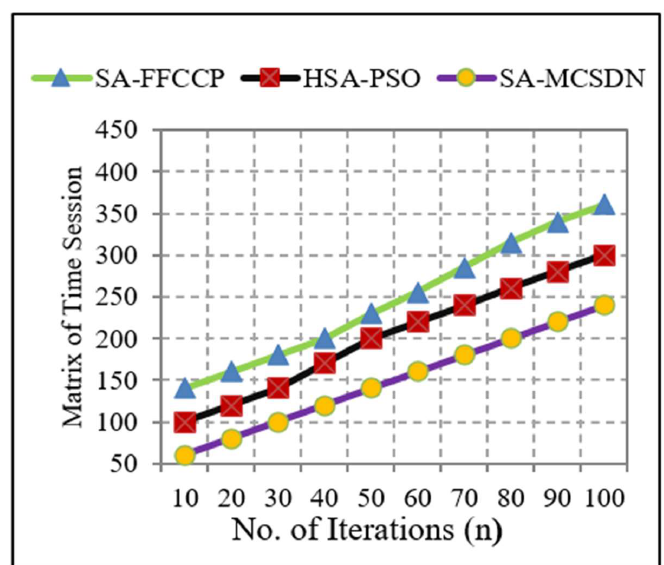
Figure 8. Comparison of the matrix of time session